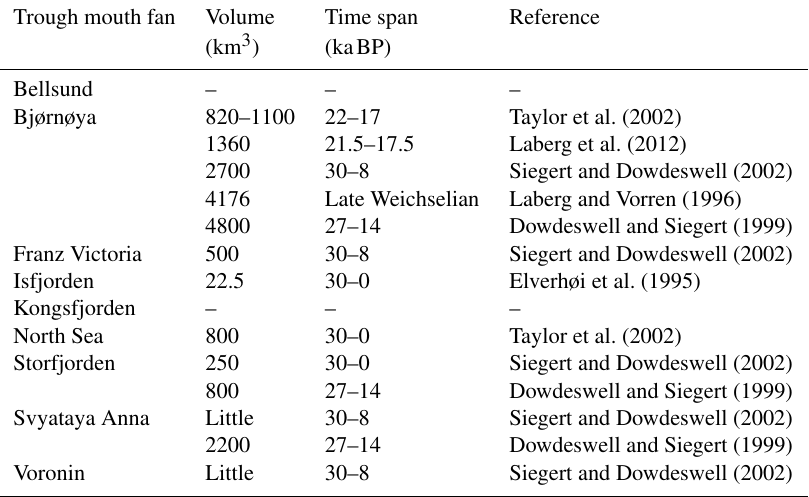
Table A1. Estimates for the volume of sediment displaced in dif- ferent events, with their time span and a reference. No estimates for Bellsund and Kongsfjorden are available, but sediment transport there is expected to be relatively small.